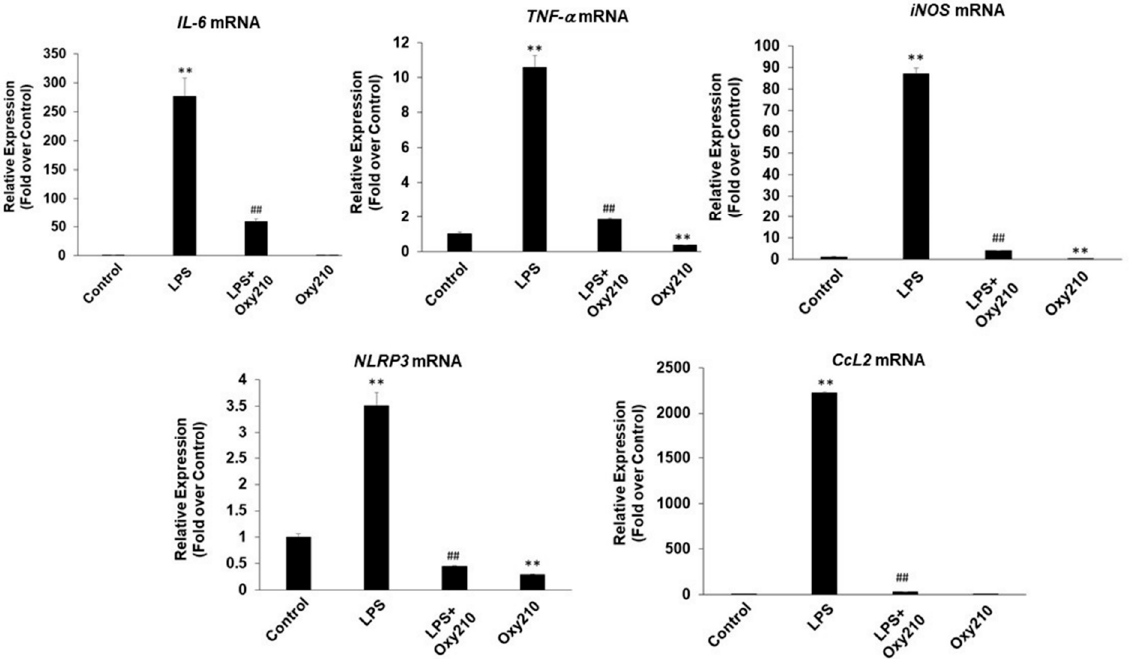
Figure 3. Inhibition of LPS-induced inflammatory gene expression in RAW264.7 macrophages by Oxy210. RAW264.7 cells were pretreated with Oxy210 (5 μ M) in DMEM containing 0.1% FBS for 24 h followed by the addition of LPS (25 ng/mL) in the absence or presence of Oxy210 (5 μ M). The 5